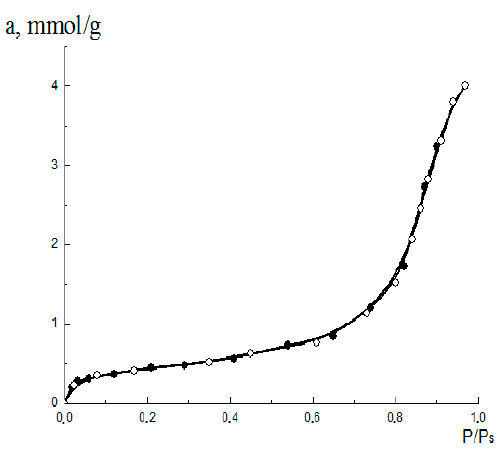
Figure 4. The adsorption ( ○ )/desorption ( ● ) isotherm for methanol vapors on the aluminum oxide material.